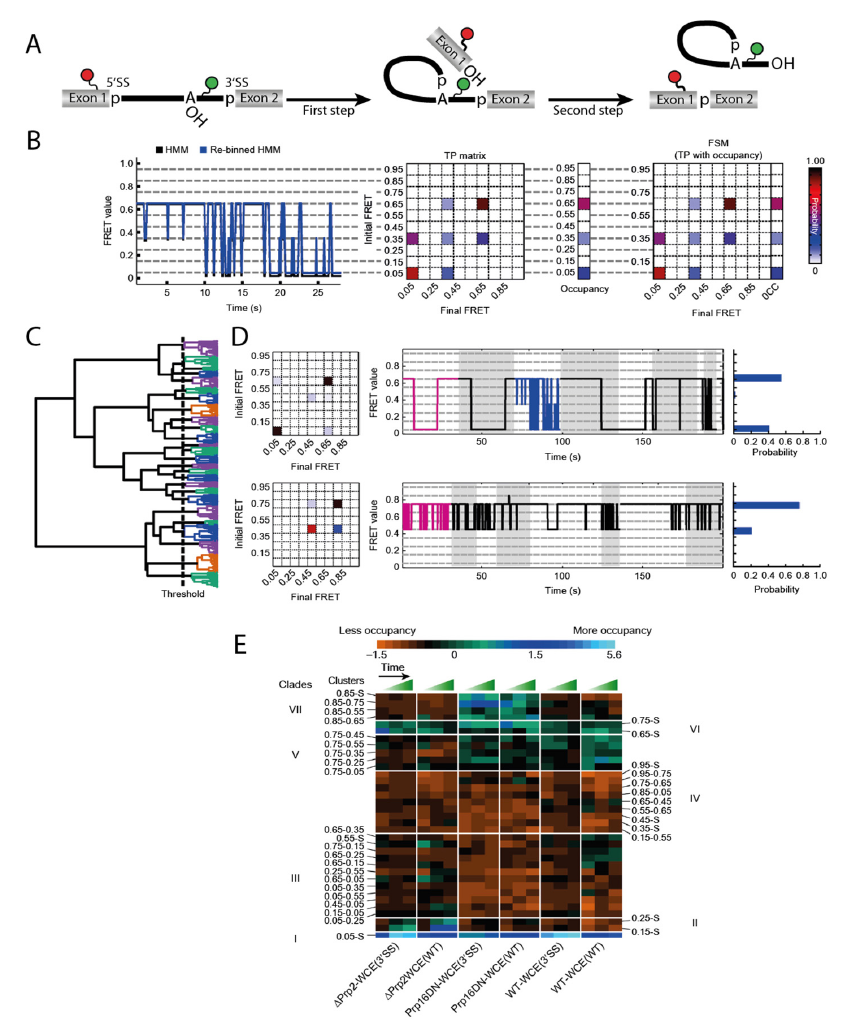
Figure 3. Workflow of the Single Molecule Cluster Analysis (SiMCAn) approach on the full splicing cycle [15]. ( A ) pre-mRNA FRET construct used in this study. During the first splicing step a lariat structure is formed and after splicing the exons are ligated and the intron-lariat released. ( B ) Hidden Markov modeling (HMM) fitted exemplary trace (black) and re-binned trace (blue) with the resulting transition probability (TP) matrix and the FRET similarity matrix (FSM). ( C ) Clustering of the molecules resulting in a hierarchical tree with every leaf representing a single molecule and sorting into 25 clusters indicated by the same color. ( D ) Representation of 2 clusters with their TP matrix, exemplary traces with the best trace in magenta and the occupancy in each state. ( E ) Second round of clustering of the clusters into 7 clades which show similar behavior under changing conditions. © 2015 Nature America, Inc. Used with permission.